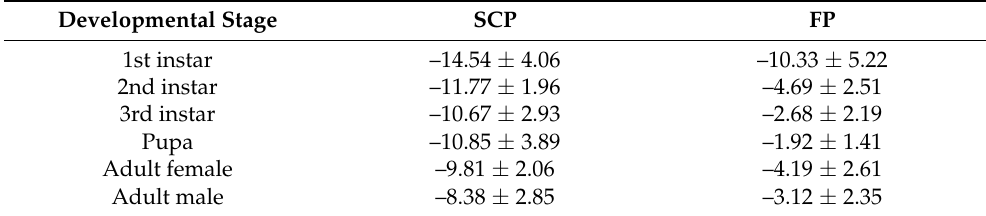
Table 1. Supercooling point (SCP) and freezing point (FP) for different life history stages of Agasicles hygrophila . All values are presented as the mean ± standard error (SE). Values are in degrees